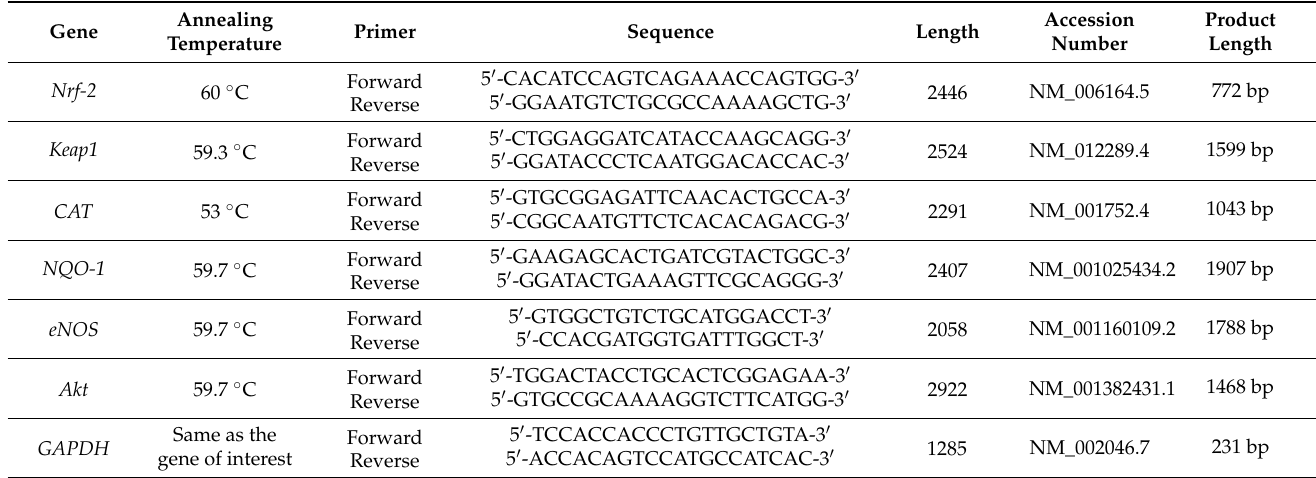
Table 1. The annealing temperatures and primer sequences for the genes of